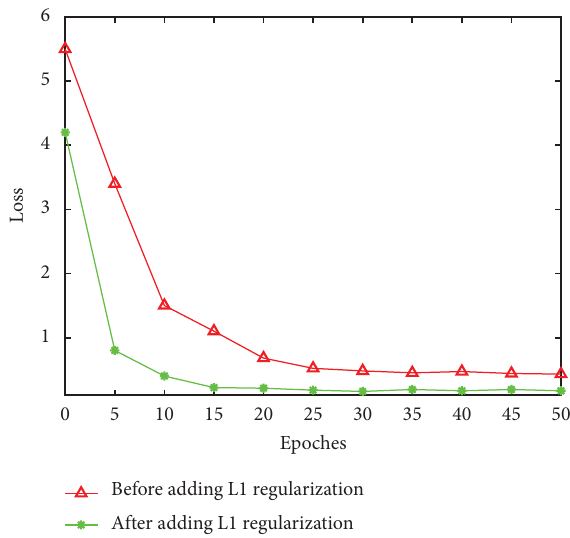
Figure 2: Te efect of diferent radial basis functions on model training.